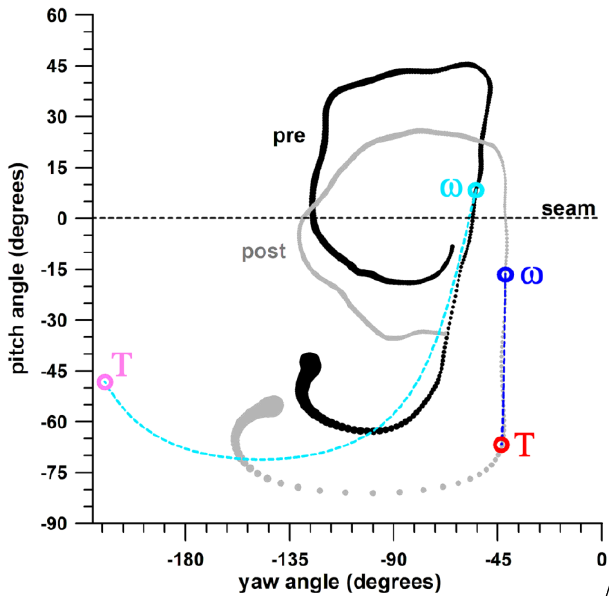
Figure 3. left subfigure: paths of the spin axes on the surface of the ball expressed as yaw and pitch angles (of the spin axis) before (pre) and after (post) intervention (same deliveries as in Figure 2); the bubble size of the pitch-yaw graph corresponds to the spin rate (the release point of the ball is at the largest bubble); ω = instantaneous spin axis vector at peak normalised precession; T = instantaneous torque vector at peak normalised precession; the dashed blue lines indicate the straight path on which the spin axis vector would move into the torque vector if the torque vector were stationary (this straight path on the surface of the ball looks curved on the pitch-yaw diagram); the angle between ω and T is 137° before and 50° after intervention (corresponding to Figure 2); right subfigure: vector diagrams of the spin axis corresponding to the pitch-yaw